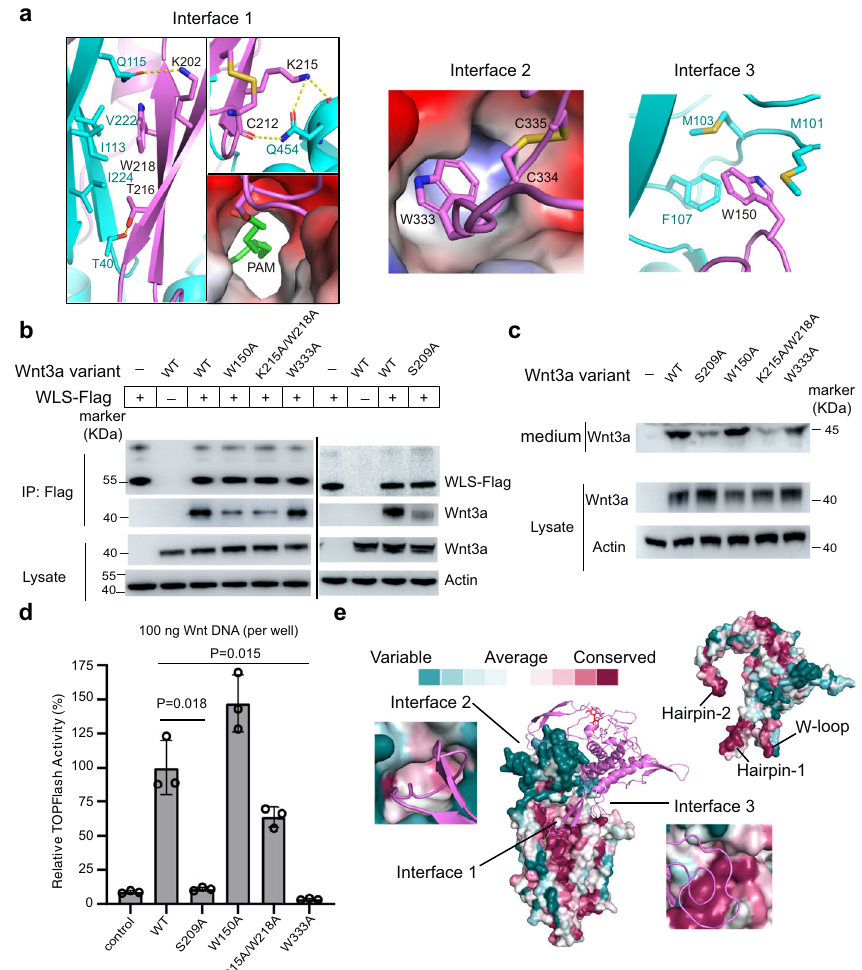
Fig. 3 Interfaces between WLS and Wnt3a. a Three major interfaces between WLS and Wnt3a and the interaction details. Residues are indicated as one- letter codes here and in all other fi gures with speci fi c residues highlighted. b Interaction validation between WLS and different Wnt3a variants through co- IP. In total 2.5 µ g /well (six-well plate) of plasmids were co-transfected into Hela cells with Wnt3a: WLS DNA ratio at 1:1. Experiments were independently performed for three times with similar results. c Secretion of Wnt variants, detected by western blotting. Experiments were independently performed for three times with similar results. d Signaling activity for different Wnt3a variants. Activity was measured by TOPFlash luciferase reporter assay. Normalized activity for WT Wnt3a is taken as 100%, and activity of Wnt3a mutants is shown as percentage activity compared to WT Wnt3a. 100 ng of Wnt3a DNA per well (24-well plate) was used during transfection. All histograms were generated from n = 3 independent measurements by GraphPad Prism 9. Statistical analysis was performed by two-sided test; mean ± S.D. e Conservation surface of Wnt3a and WLS. The highly conserved regions involved in binding at interfaces are